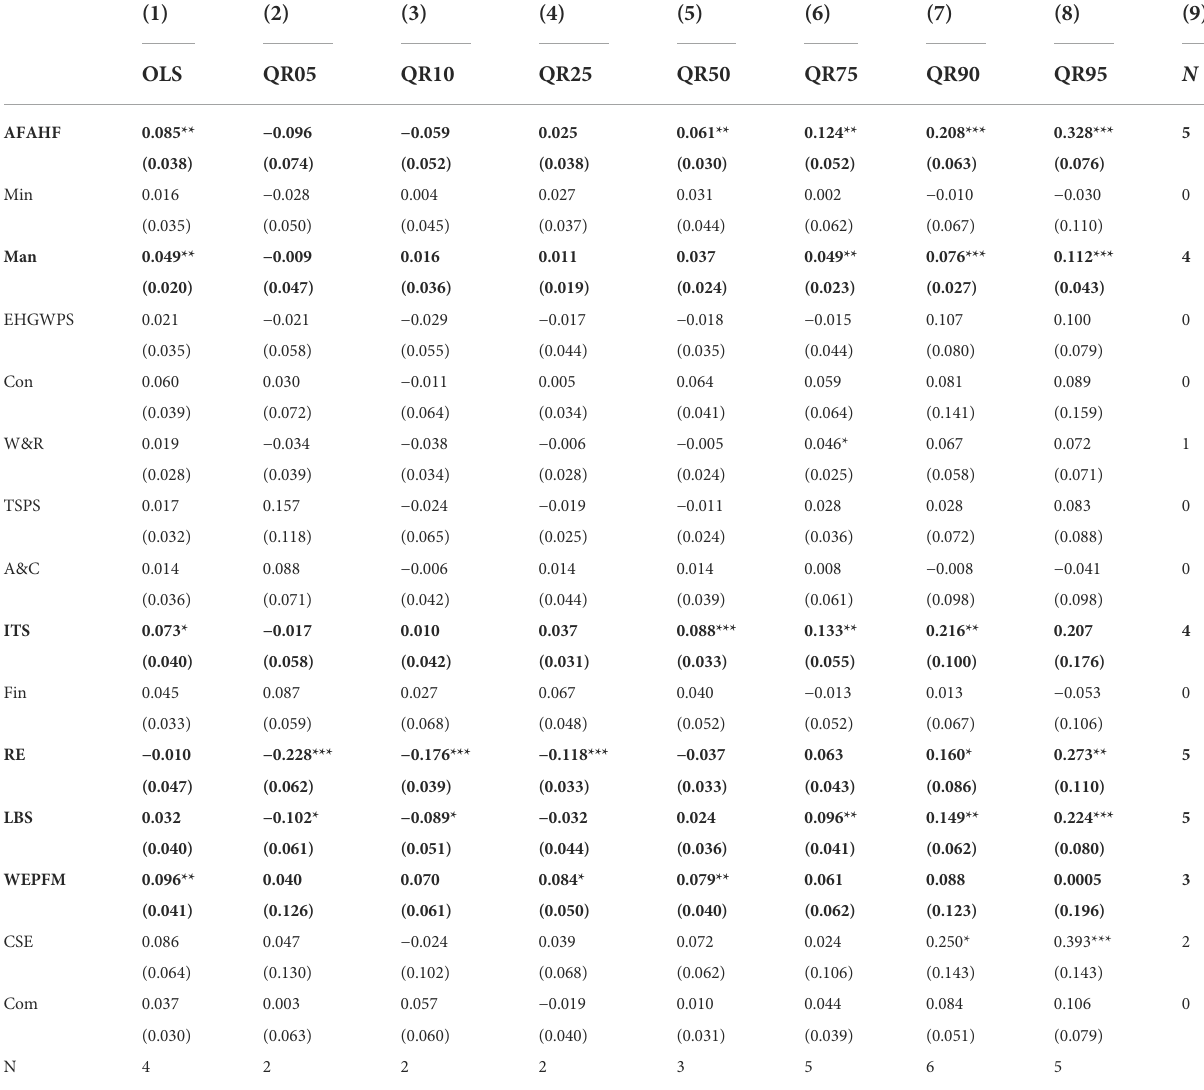
TABLE 7 Robustness check Ⅰ : OLS and quantile regressions considering quarterly precipitation